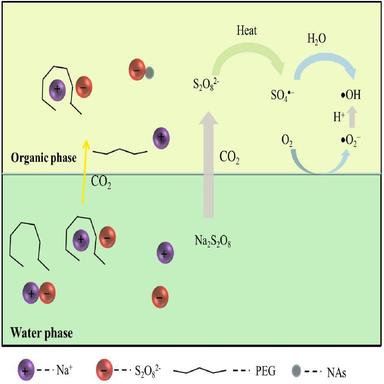
Schematic diagram of phase transfer process and degradation Mechanistic.